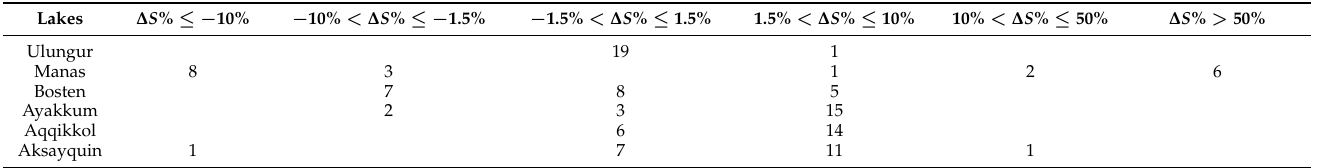
Table 3. Distribution of annual relative rates of change in the areas of six